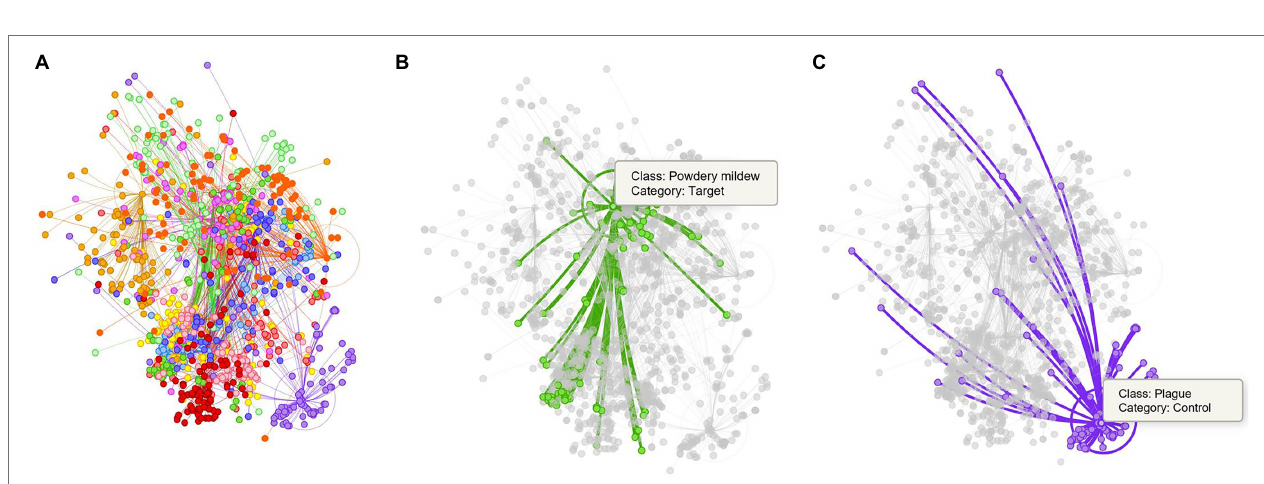
FIGURE 6 | Distribution of features of target and control classes in the space domain. (A) Sampling distribution of the model trained without control classes. (B) Sampling distribution of the model trained with control classes. Each circle represents one class, and its radio depends on the number of samples and the dispersion of features. Solid lines and dashed lines correspond to target classes and control classes, respectively.